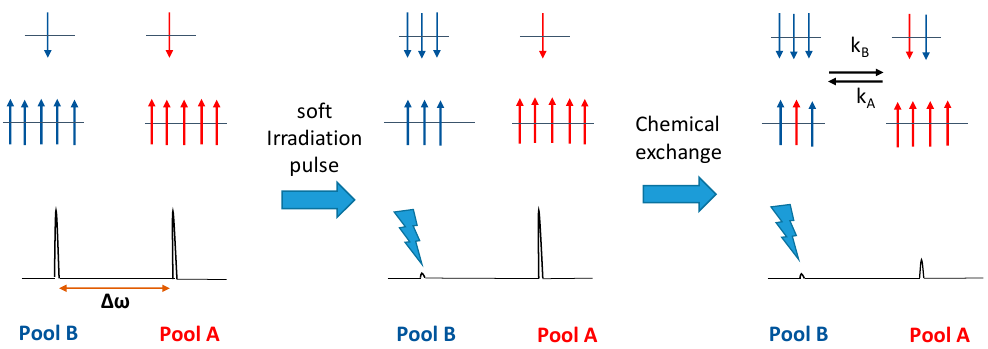
Figure 9. Schematic representation of the distribution of proton spins and the simulated NMR spectra when a pre-saturation pulse is applied, and the system is under a chemical exchange. As a result, a negative contrast is produced by the difference of chemical exchange in between pools; this is known as CEST.